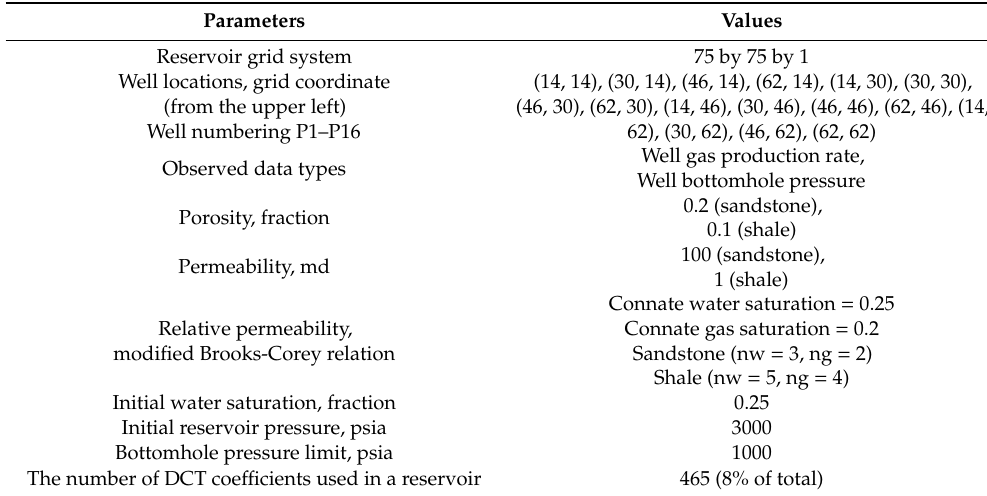
Figure 8. Water saturation distribution maps of the reference field on the observation time. Table 2. Simulation and reservoir Table 2. Simulation and reservoir conditions.